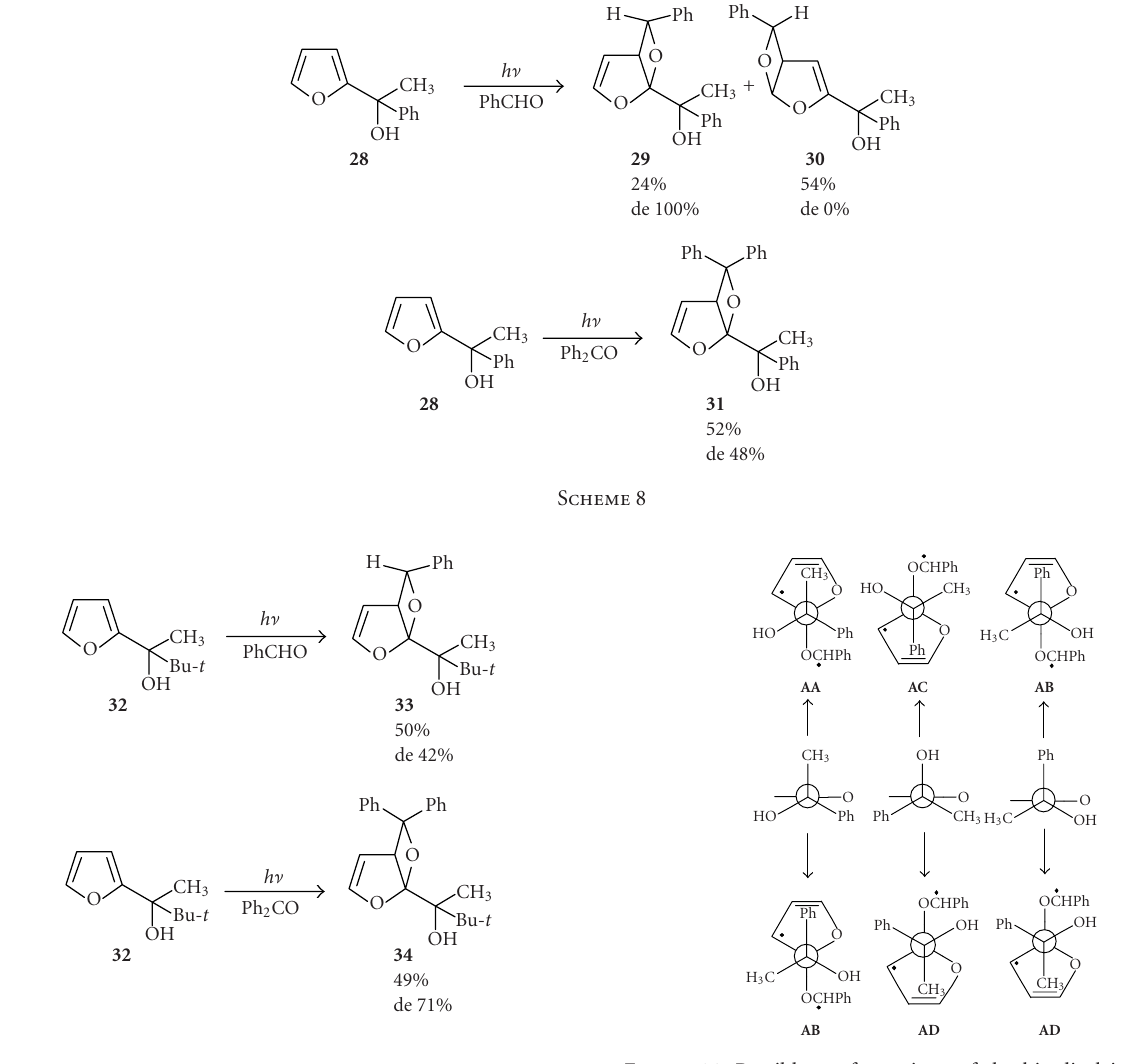
Figure 14: Possible conformations of the biradical intermediate from the reaction of 1-methyl-1-phenyl-1-(2-furyl)methanol with benzaldehyde.